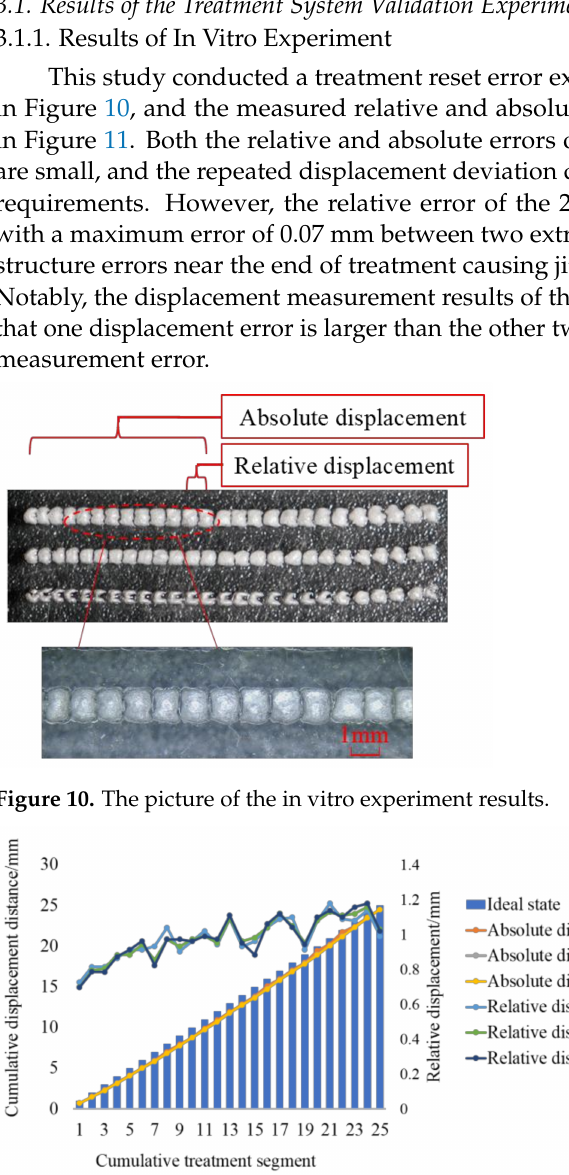
Figure 11. Error statistics